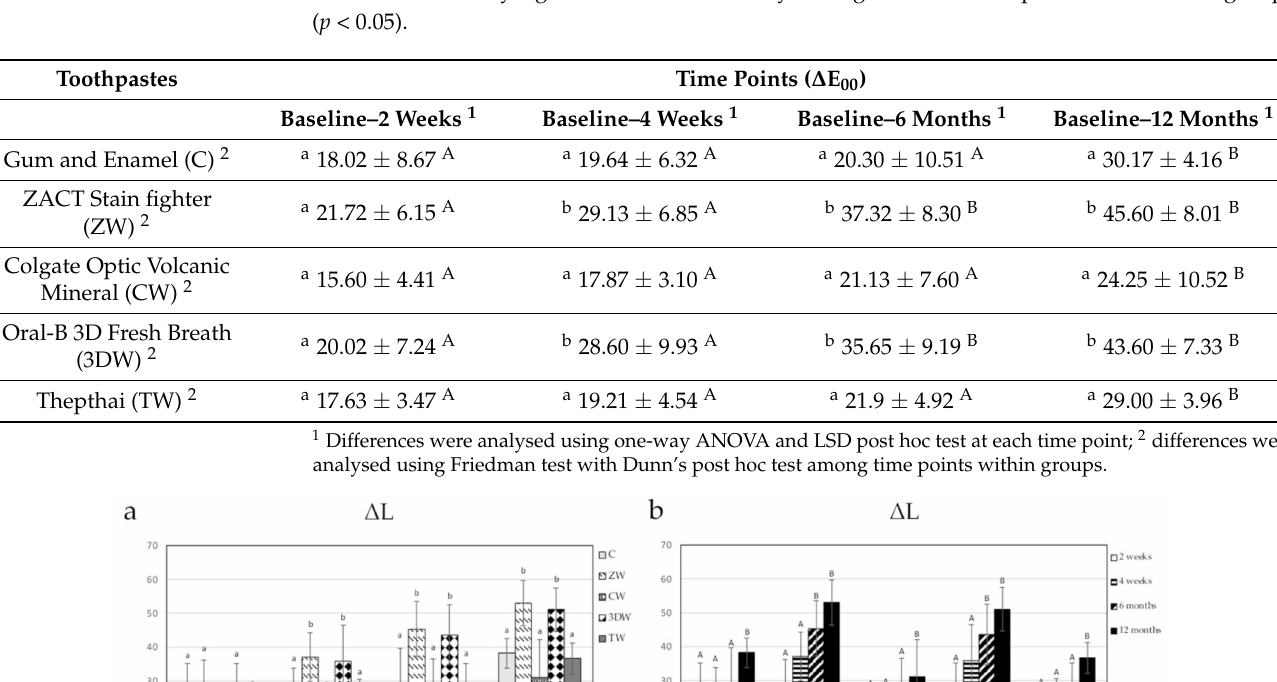
Table 5. Mean and standard deviation of ∆ E 00 (difference between baseline and period of time) after brushing. In the same column, different superscript lowercase letters indicate statistically significant differences among different toothpaste groups. In the same line, different superscript capital letters indicate statistically significant differences only among the evaluation periods in the same groups ( p < 0.05).